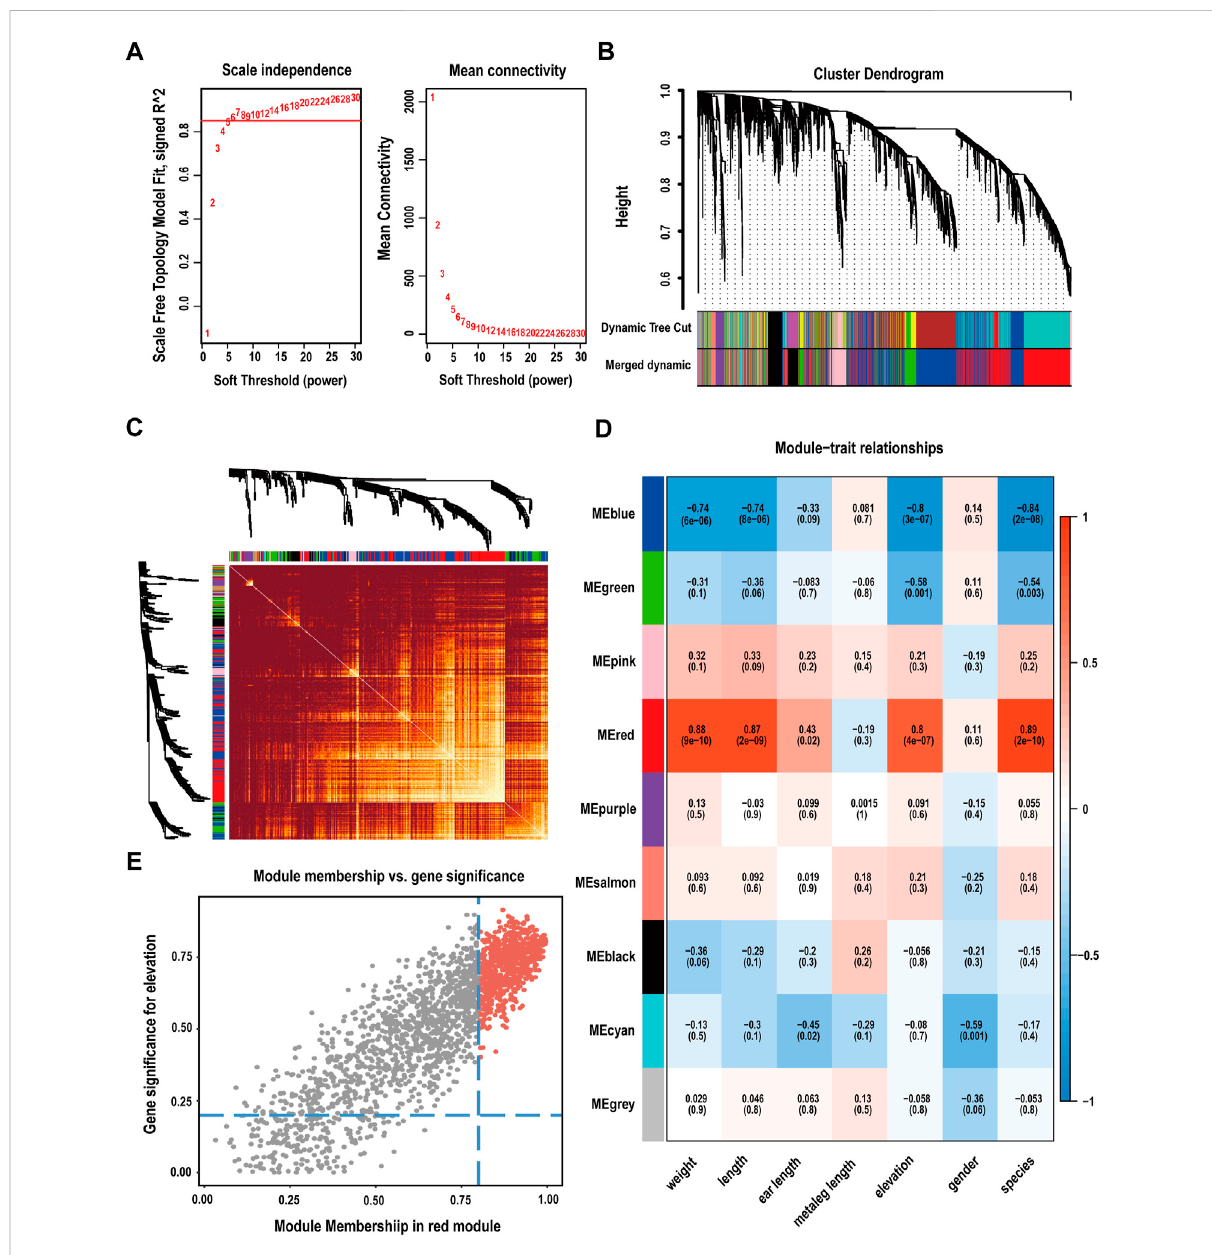
FIGURE 3 Constructionofaweightedgenecoexpressionnetwork. (A) Analysisofsoft-thresholding powerbasedon scaleindependence(left)and means connectivity(right). (B) Clusterdendrogramofgenes.Modulesconsideredtohavehighsimilarityweremixed. (C) Networkheatmapplotsofallgenes in the WGCNA. (D) Heatmap of the correlations between modules and phenotypes. Altitude-related genes were mainly enriched in the red module. (E) Scatter plot of correlations between modules and phenotypes, screening of genes as hub genes according to |MM| > 0.8 and |GS| > 0.2 (red